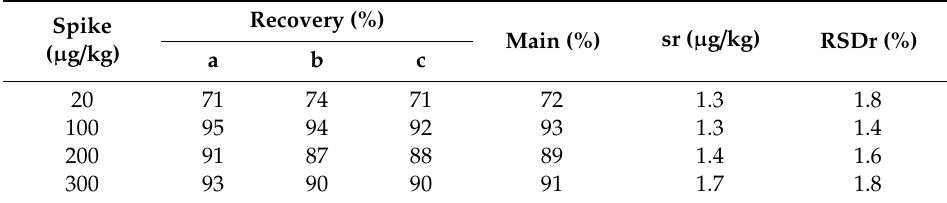
Table 1. Recovery of zearalenone (ZON) from spiked maize oil samples. Recovery (%) Main (%) sr (µg/kg) RSDr (%) a b c Spike (µg/kg) 20